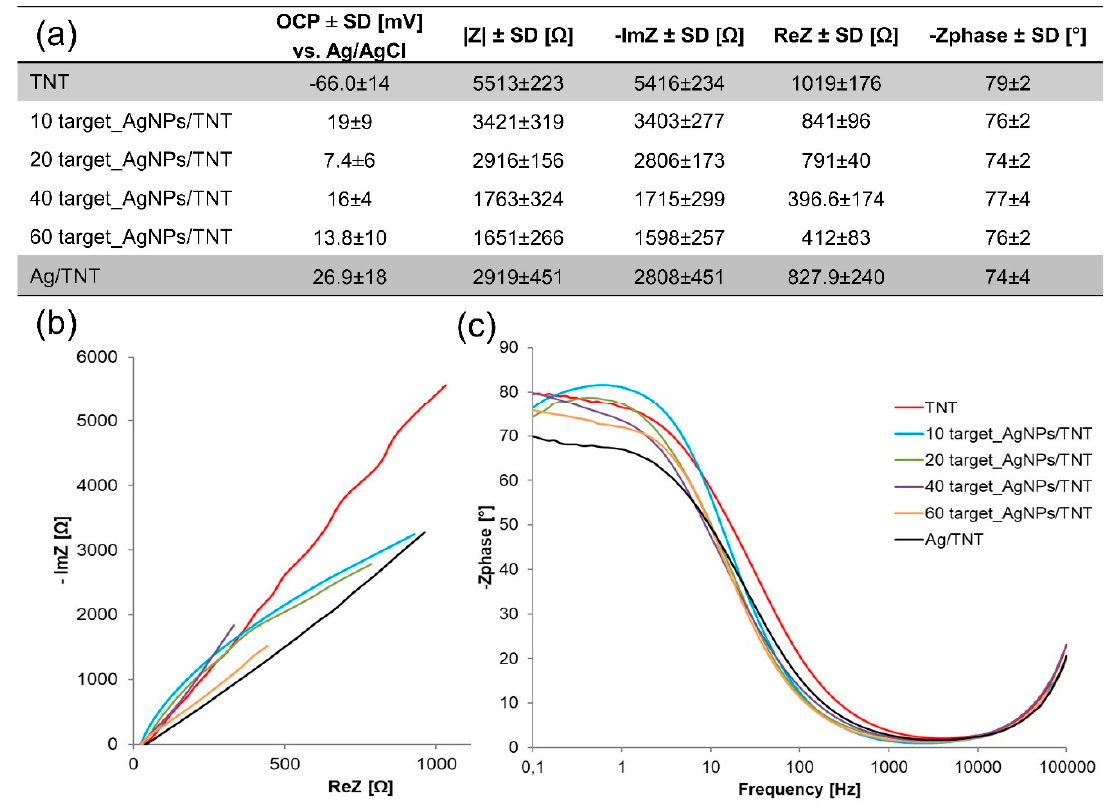
Figure 9. Chart presenting deposition duration dependency on the: ( a ) silver weight content and ( b ) thickness of silver layer in produced AgNPs/TNT platforms.